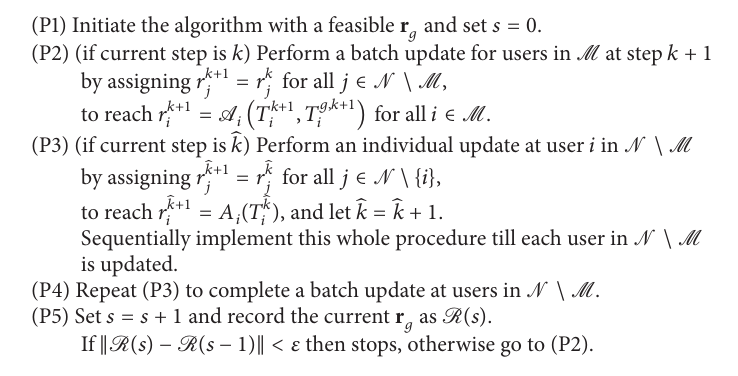
Algorithm 1: The scheme to locate the user-grouping NEP.